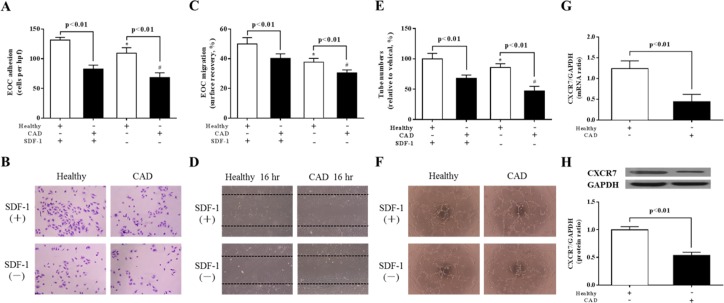
Down-regulation of CXCR7 results in reduced in vitro functions of EOCs from CAD patients.EOCs from CAD patients display reduced homing and angiogenic functions in comparison with healthy subjects. A-D: Quantification analysis (A and C) and representative photographs (B and D) of adhesion and migration of EOCs with/without SDF-1 (100 ng/ml, *P<0.01, #P<0.01 vs. SDF-1 induced, n = 5 per group). E: Tube number was incorporated into tube-like structures. (*P<0.01, #P<0.01 versus SDF-1 induced; n = 5 per group). F: Representative images of complete tube formation (original magnification ×10 [top] and ×10 [bottom]). G-H: Representative quantitative and photographs analyses of CXCR7 mRNA and protein expression in EOCs (n = 5 per group).